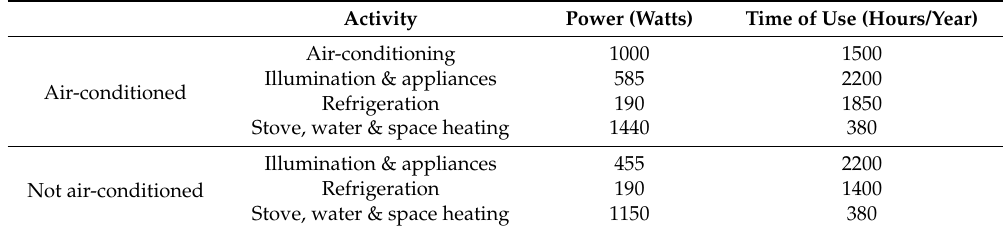
Table 4. Averaged power and time of use of different activities in air-conditioned and not air-conditioned dwellings in Mexico [35,36].